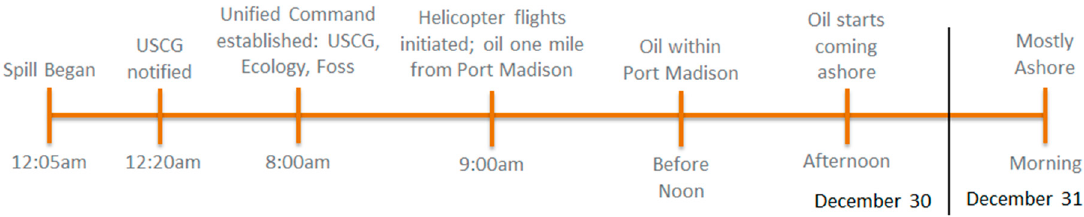
Figure 1. Approximate timeline of events, as recorded in ENTRIX 2005.